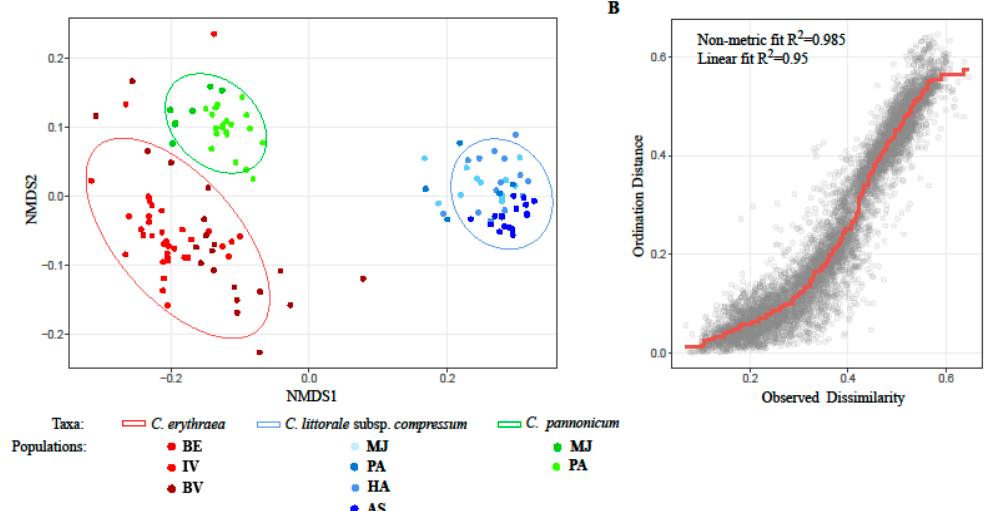
Figure 4. Nonmetric multidimensional scaling (NMDS) based on the Bruvo distances between individuals. ( A )—NMDS scatterplot; populations are indicated by different colors as shown in the legend. Each taxon is encircled by a 95% confidence ellipse: red— C. erythraea , green— C. pannonicum , blue— C. littorale subsp. compressum . ( B )—Shepard diagram (goodness-of-fit scatterplot) of observed Bruvo distances and NMDS transformed distances. Stress =